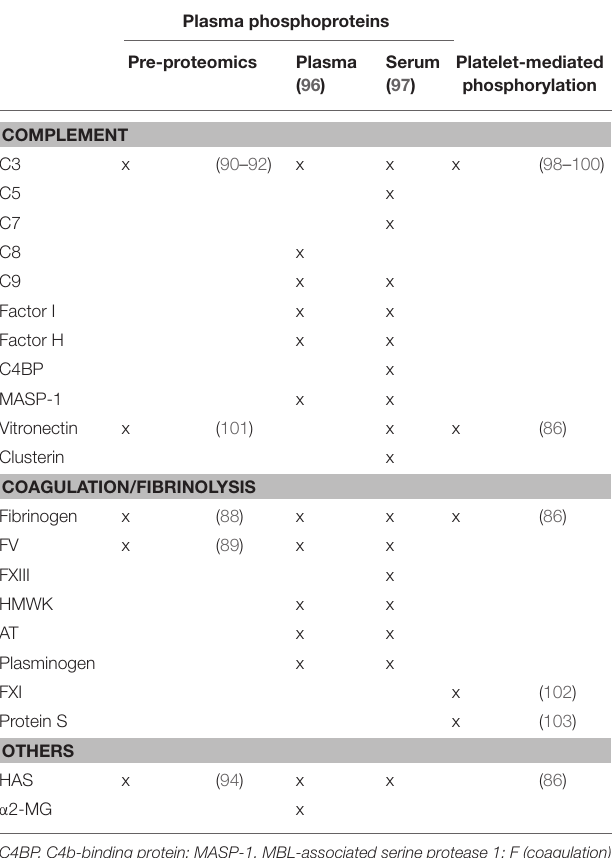
TABLE 2 | Complement- and coagulation-related plasma phosphoproteins.